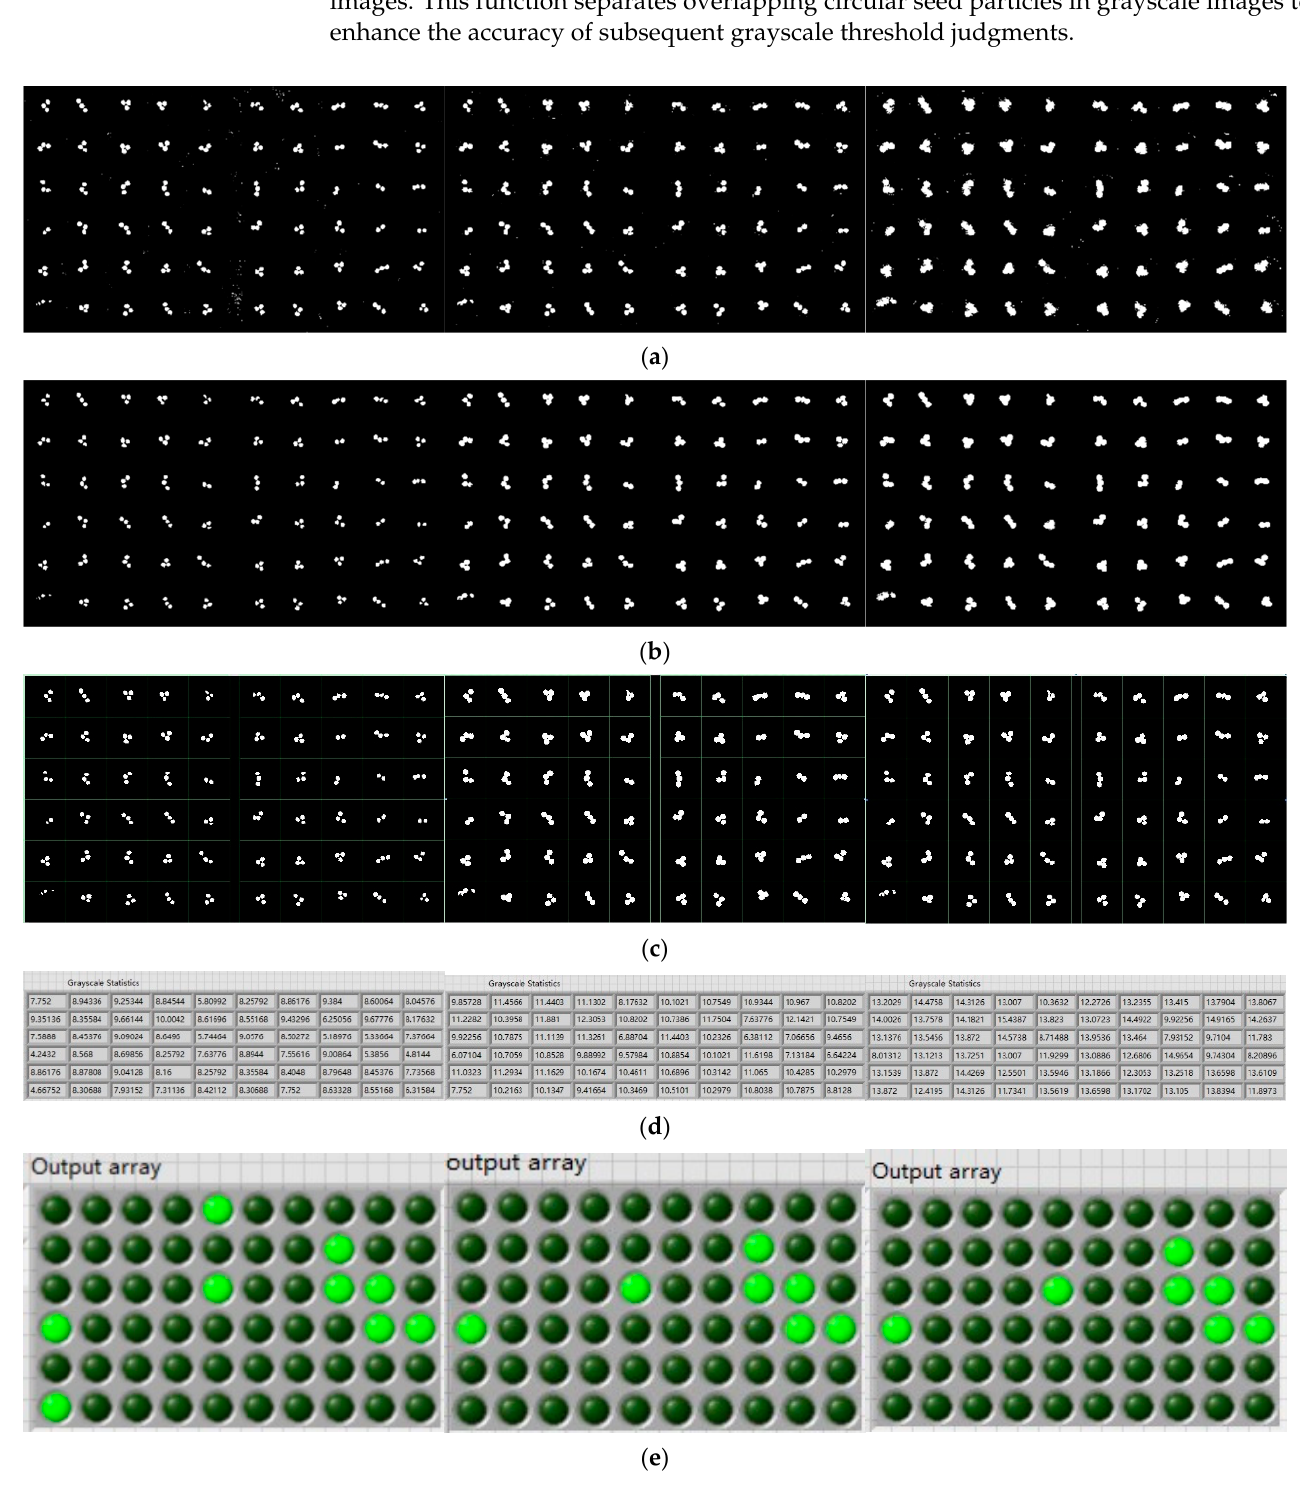
Figure 11. Image processing flow. ( a ) RGB space, HSL space, HSV space. Color thresholding and image grayscale; ( b ) RGB space, HSL space, HSV space. Morphological processing and H-Dome algorithm; ( c ) RGB space, HSL space, HSV space. Image region segmentation; ( d ) RGB space, HSL space, HSV space. Statistical data analysis; ( e ) RGB space, HSL space, HSV space. Results of data analysis. Note: The lower left corner of the RGB space in Figure 11e is incorrectly identified as miss-seeding tray holes.